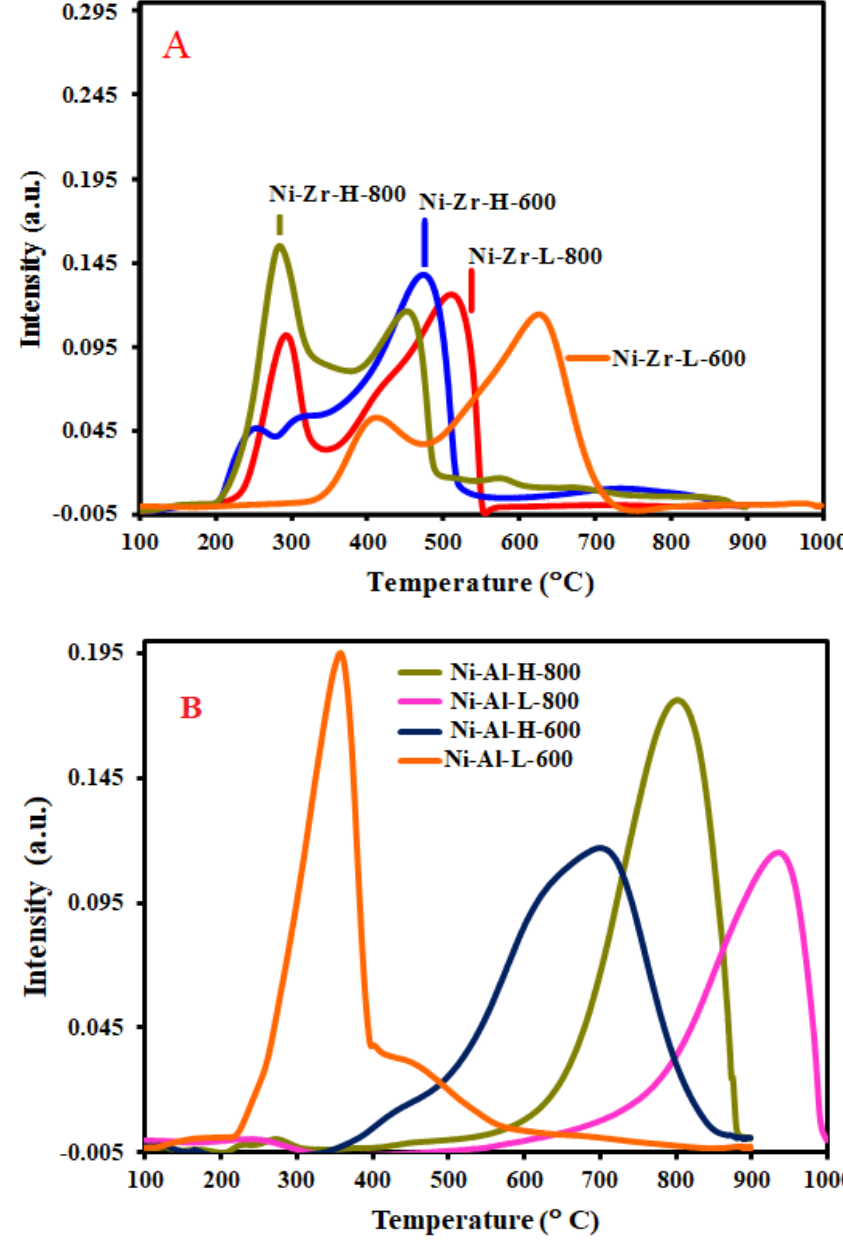
Figure 4. H 2 TPR profiles ( A ) Zr-supported catalysts, ( B ) Al-supported catalysts.